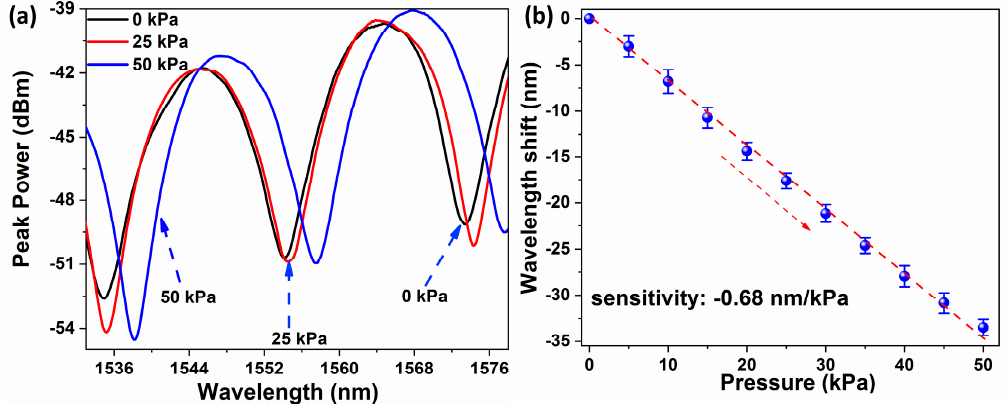
Figure 6. Response of spectral minima of the FPI sensor to changes in pressure ( a ) and the corresponding average shift in wavelength minima along with error bars ( b ).